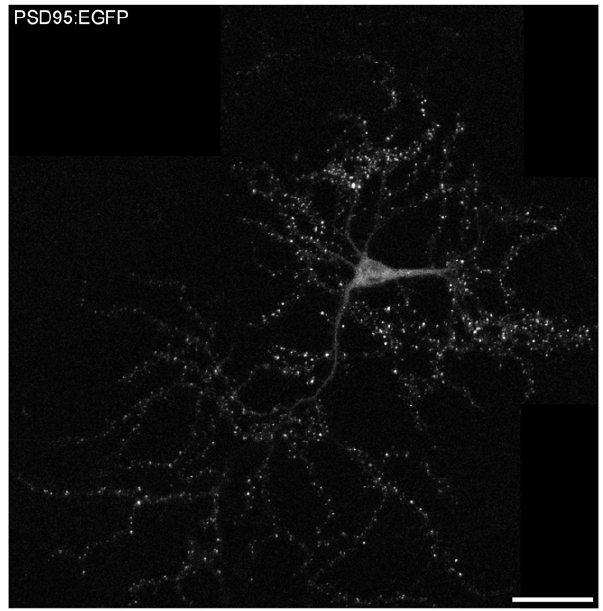
Figure 1. A mouse cortical neuron expressing PSD-95:EGFP. A composite image of a cortical neuron from a Nlgn-1 KO mouse expressing PSD-95 tagged with EGFP. Most bright puncta represent postsynaptic densities of dendritic spines. 17 days in vitro . Bar, 50 m m.